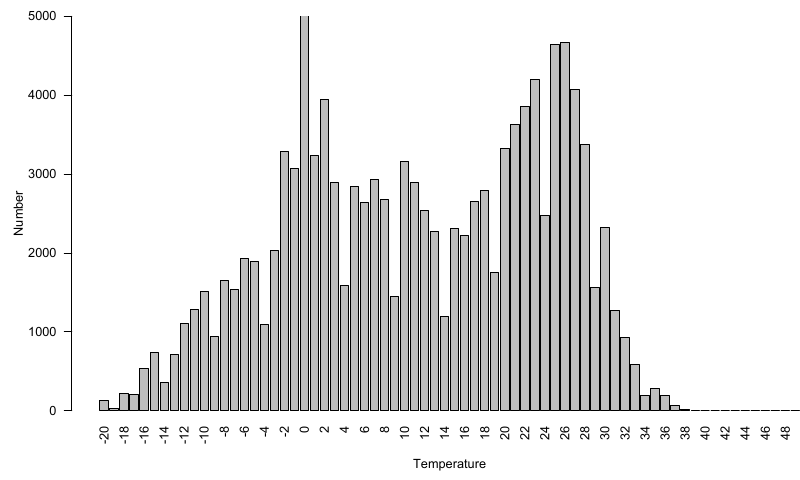
Figure 4. The distribution of the number of images vs. different temperature values in the Glasner- Exp